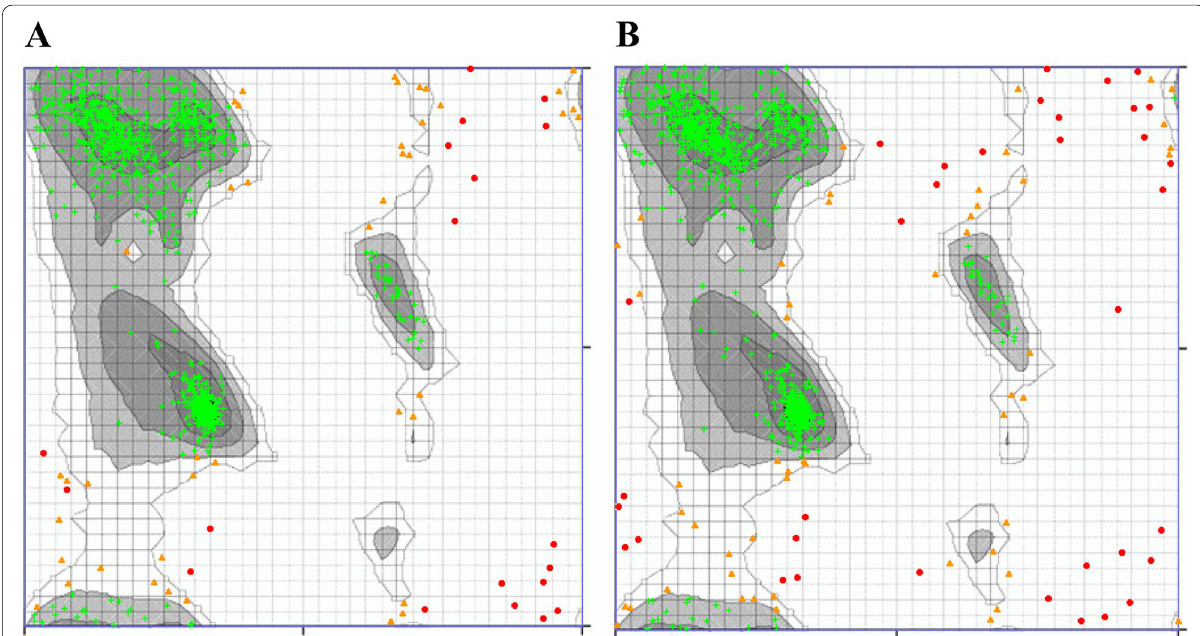
Fig. 5 Ramachandran plot of A : PAZ domain-loss ( A. lyrata ; XP 002873991.1) and B : PAZ domain containing ( A. thaliana ; NP 197532.3) DCL protein. The plot calculation was done by uploading the PDB-predicted file to the Ramachandran plot server (https:// zlab. umass med. edu/ bu/